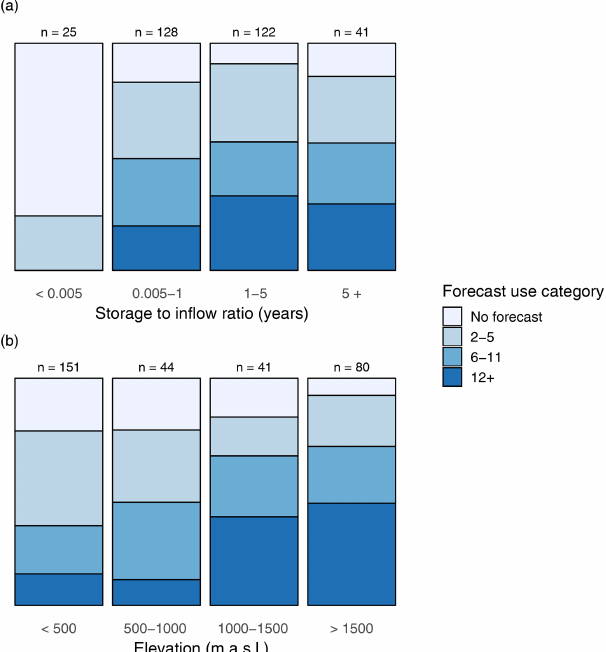
Figure 6. Stacked (100%) bars showing the distribution of dams by detected forecast horizon within categories of (a) storage ra- tio and (b) elevation. Forecast-use categories are no forecast, 2– 5 weeks ahead of the horizon, 6–11 weeks ahead of the horizon, and 12 weeks or greater ahead of the horizon. Maximum detected horizon assumes that the horizon is detected in the horizon curves for at least 3 consecutive weeks with the policy fit ( R 2 ) exceeding 0.5 in each